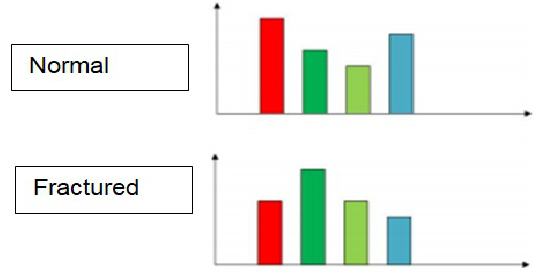
Figure 3. ‘Word’ creation of each image